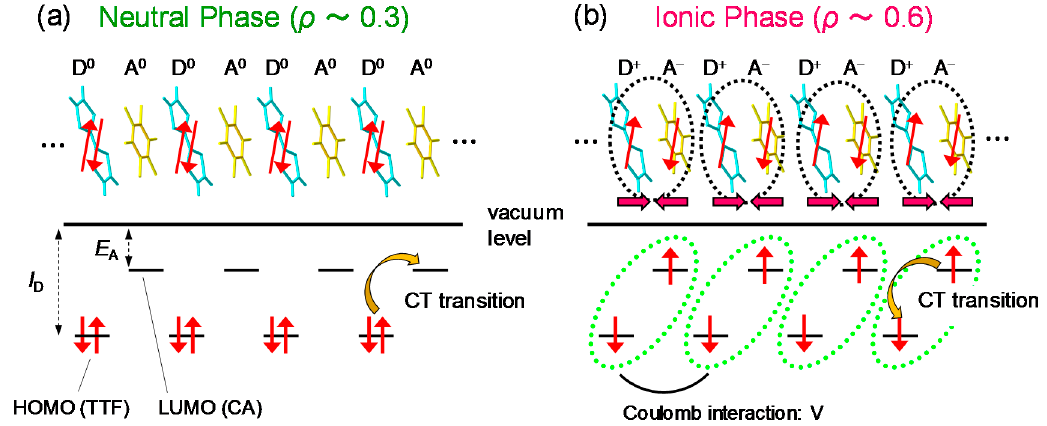
Figure 3. ( a , b ) Schematic of electronic structures in ( a ) the neutral phase and ( b ) the ionic phase of TTF-CA. Ovals in ( b ) show dimers.